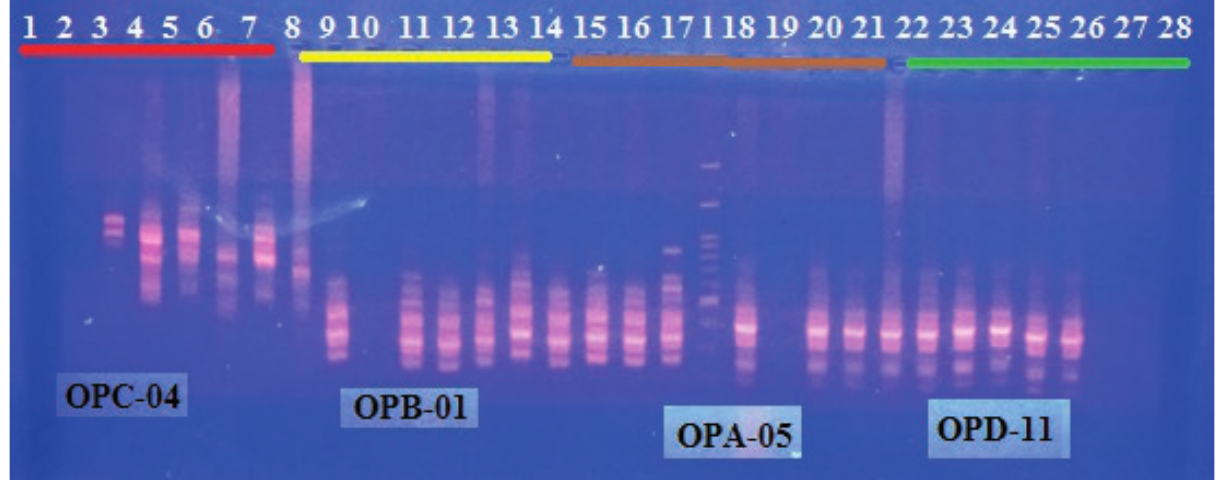
Figure 4. Gel Electrophoresis image of DNA fragments of Malva species. L = Ladder 100 bp. Arrows show polymorphic bands.1,8,15,22: Malva neglecta 2,9,16,23: Malva parviflora 3,10,17,24: Malva pusilla . 4,11,18,25: Malva sylvestris 5,12,19,26: Malva verticillata 6,13,20,27: Malva nicaeensis 7,14,21,28: Malva